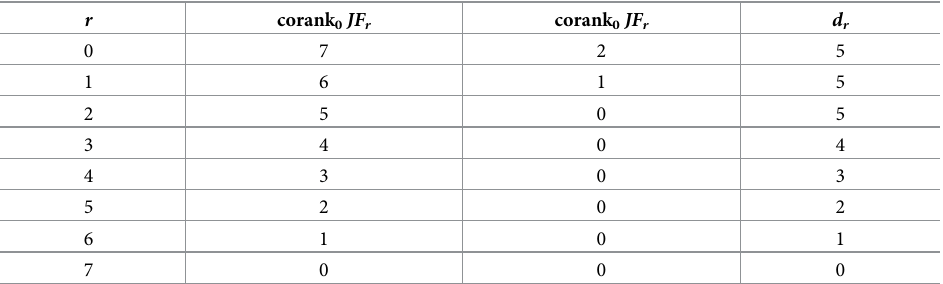
Table 4. Summary of computations showing (8) is